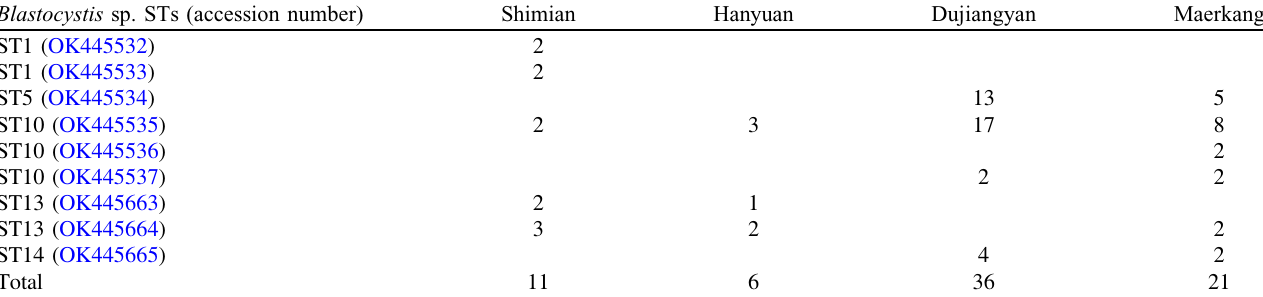
Table 2. Subtype distributions from different